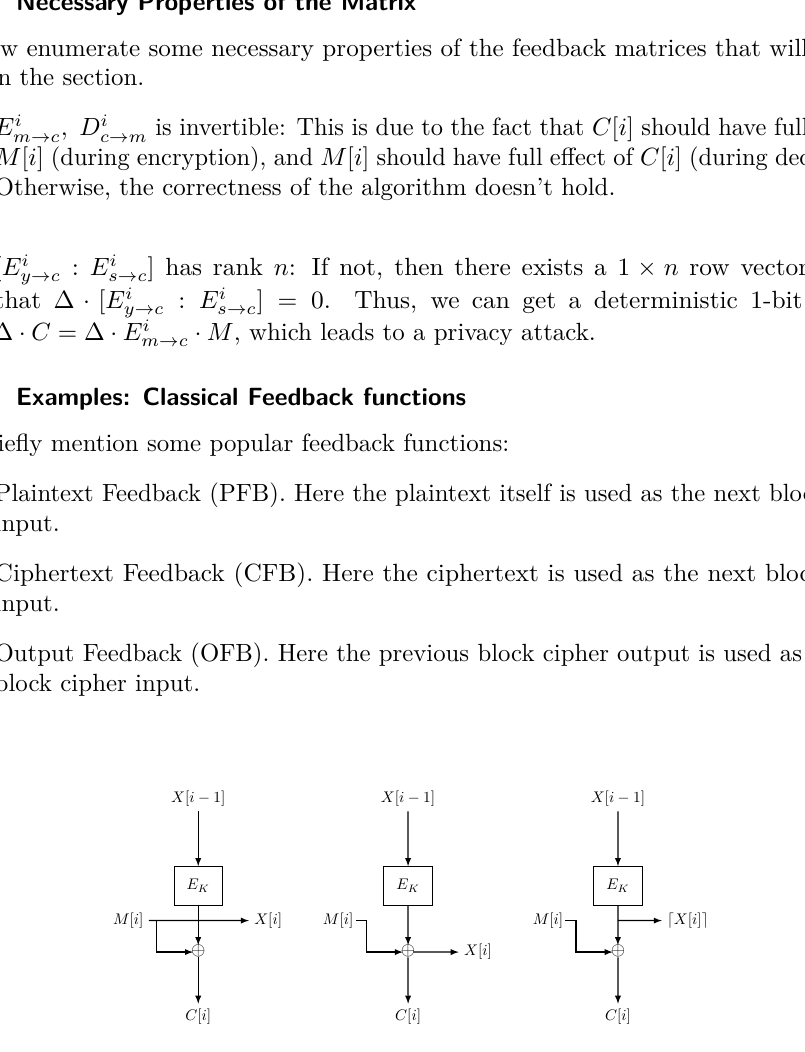
Figure 2: Types of Feedback: (i) PFB, (ii) CFB and (iii) OFB. This figure doesn’t